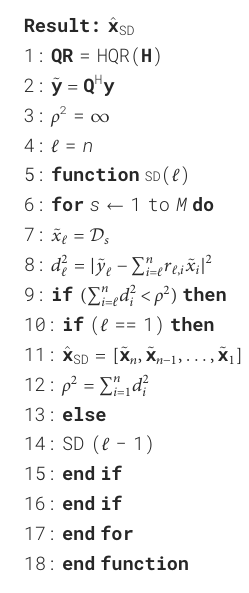
Algorithm 3. Sphere Detector.